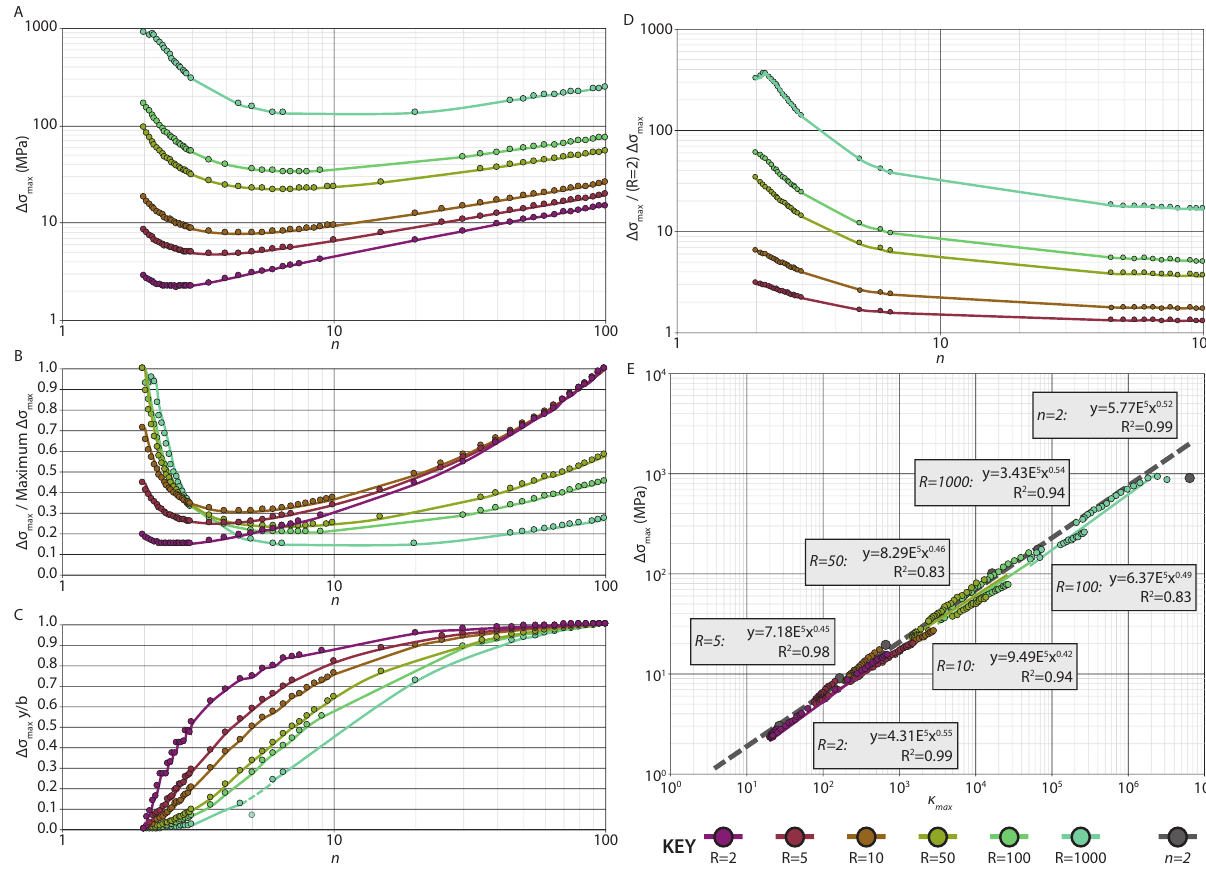
Figure 5: The relationship between modelled stress change and tip zone curvature. [A] Maximum modelled tensile